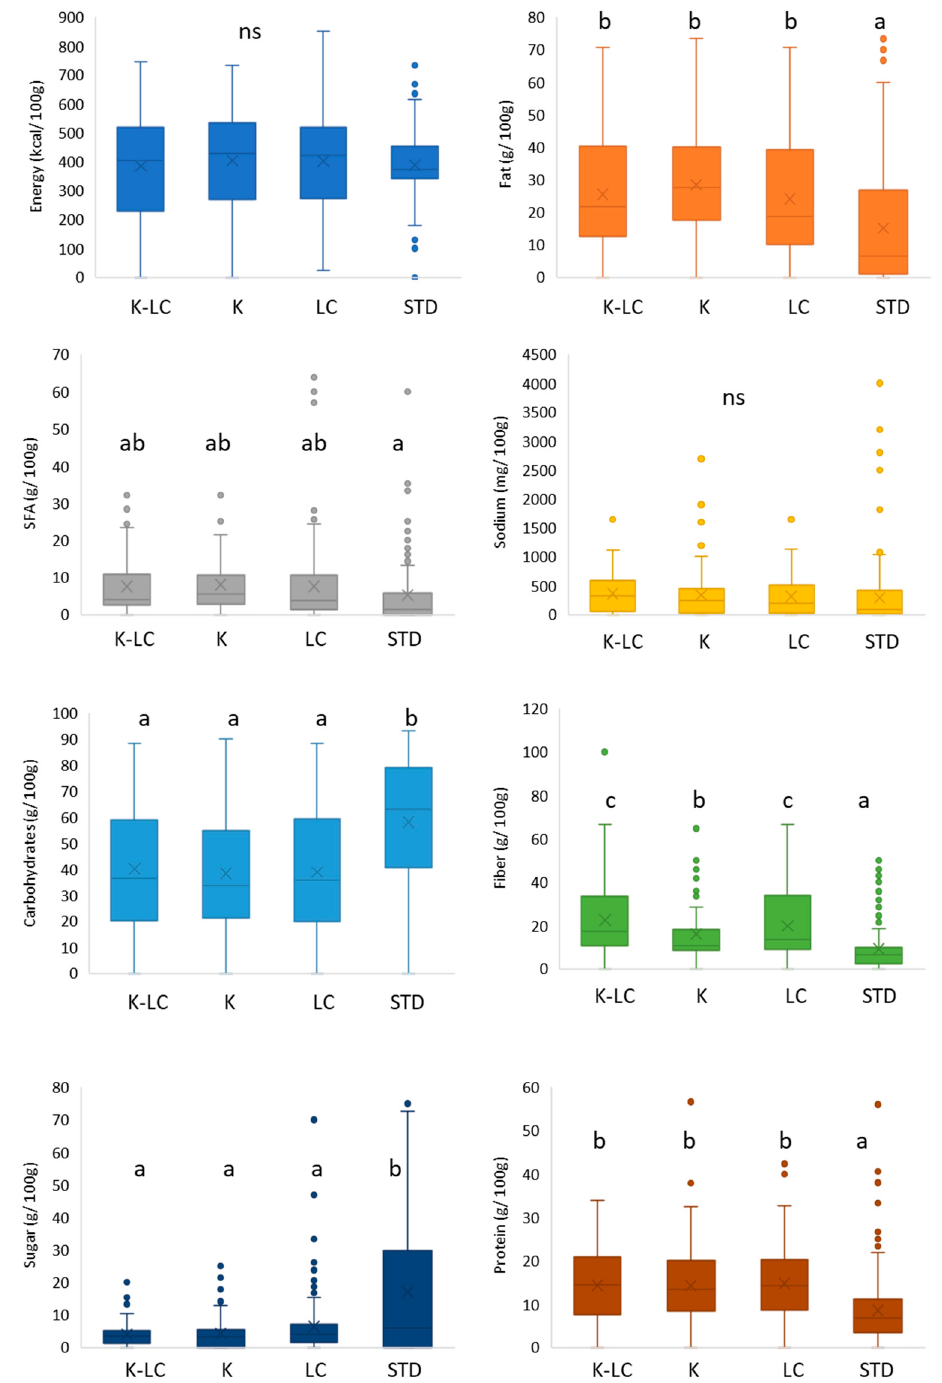
Figure 2. Nutritional composition of gluten-free flour mixes labeled ketogenic and/or low carb. K-LC: ketogenic and low carb; K: ketogenic; LC: low carb; STD: standard; different letters indicate significant difference at p < 0.05; ns: non-significant; the box-plot legend: the box is limited by the lower (Q1 = 25th) and upper (Q3 = 75th) quartile; the median is the horizontal line dividing the box; whiskers above and below the box indicate the 10th and 90th percentiles; outliers: are the points outside the quartile 10–90th